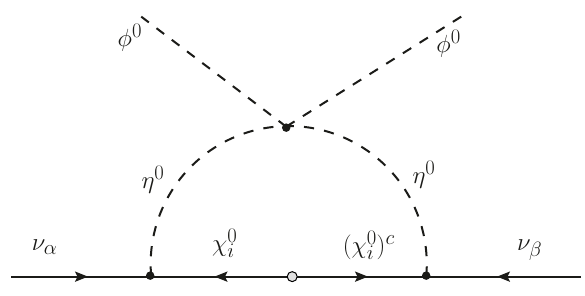
Figure 1 . One-loop diagram that generate neutrino